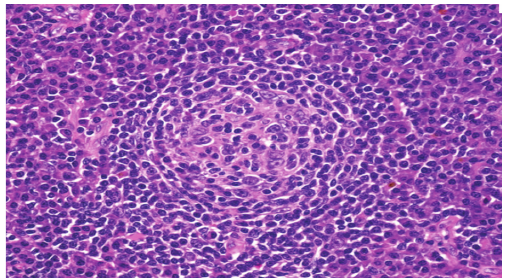
Figure 2: Axillary lymph node biopsy showing plasma cell prolifer- ation in the interfollicular